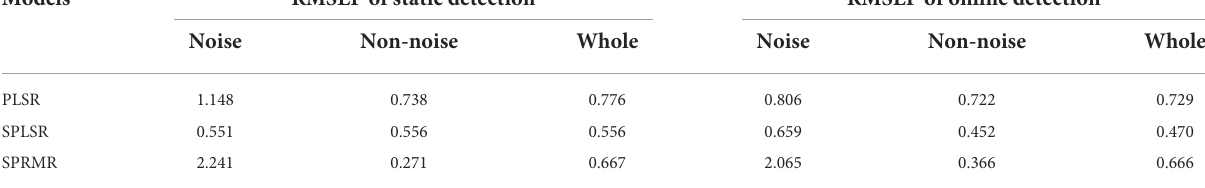
TABLE 4 The RMSEP of the prediction set including 10 noise samples with SNR of 10.